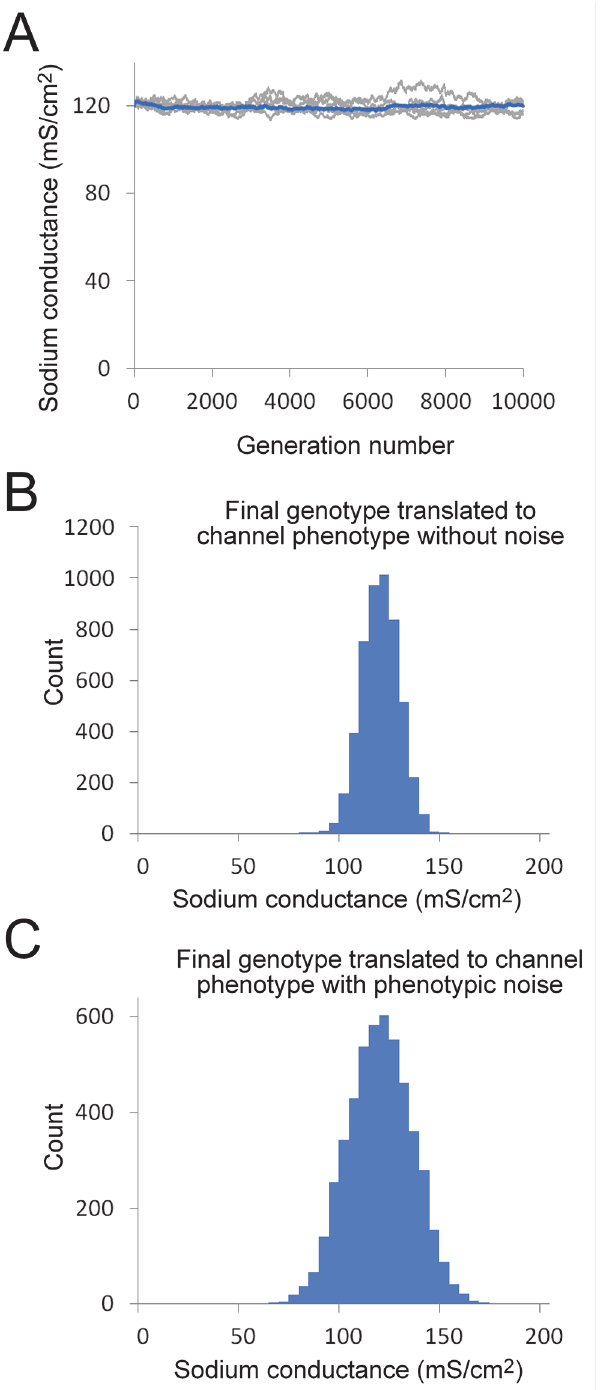
Fig 5. Effect of selection for action potential conduction on sodium channel expression over successive generations in the presence of phenotypic noise. A. Evolution of sodium conductance phenotype with the fitness function shown in Fig 4C in combination with phenotypic noise. The average sodium conductance within the population remains stable over time (10000 generations, population size = 5000). The blue line is the average value of ten simulation runs and five independent runs are shown in light grey on the same graph. The average final conductance value was 120.4 ± 4.4 mS/cm 2 (mean ± S.D., n = 10). B. Histogram showing representative final phenotype distribution translated directly from the